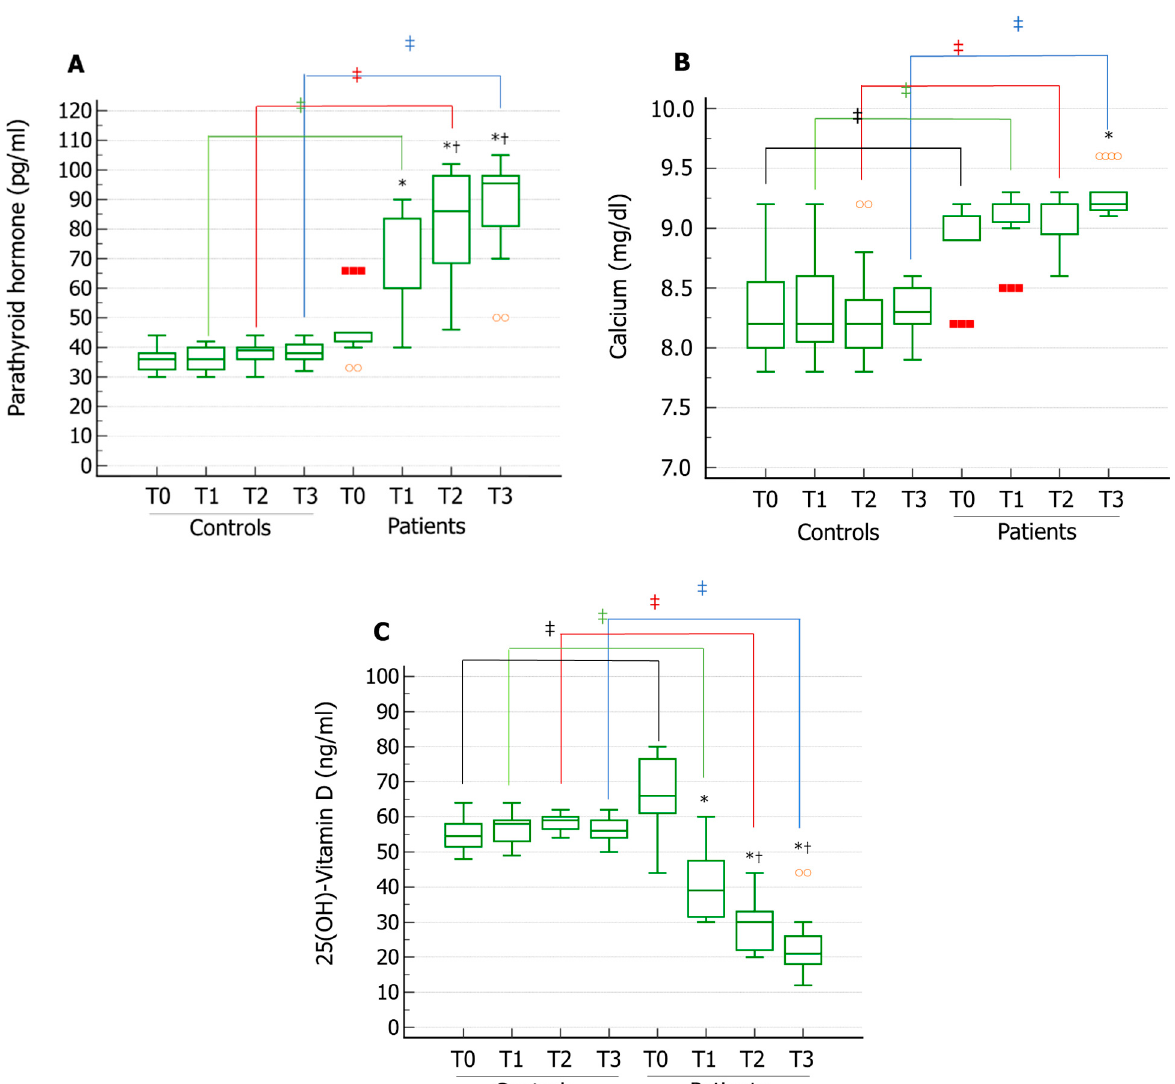
Figure 1. Serum levels of parathyroid hormone (PTH), calcium, and 25(OH)-Vitamin D in patients with III degree bilateral varicocele and varicocelectomized controls. Serum PTH levels significantly increased after one (T1), two (T2), and three (T3) years of follow-up compared to the values at enrolment (T0) in the patient group. Compared to controls, patients showed significantly higher PTH serum levels at T1, T2, and T3. ( A ). Serum calcium levels were significantly higher in T3 vs. T0 in the patient group. Compared to controls, patients showed significantly higher calcium serum levels at each assessed time. ( B ). Serum 25(OH)-Vitamin D levels significantly decreased over time in the patient group. Compared to controls, patients showed significantly lower 25(OH)-Vitamin D serum levels at each assessed time. (Panel ( C )). * p < 0.05 vs. T0; † p < 0.05 vs. T1; ‡ p < 0.05.